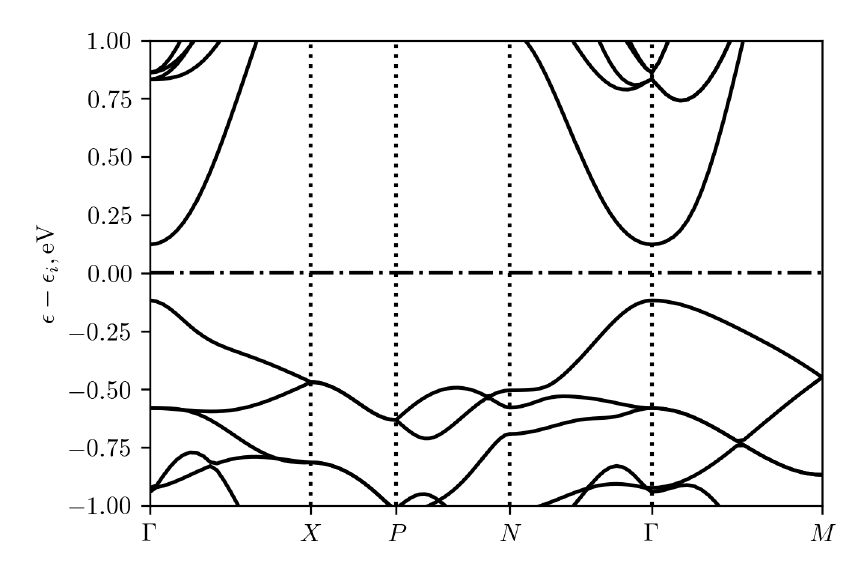
Figure 8. Band structure of Ag 3 CuS 2 (I4 1 /amd), calculated using generalized gradient PBE approxi- mation. Energy is counted from the middle of the band gap (cid:101) i . Special points in the Brillouin zone are denoted according to